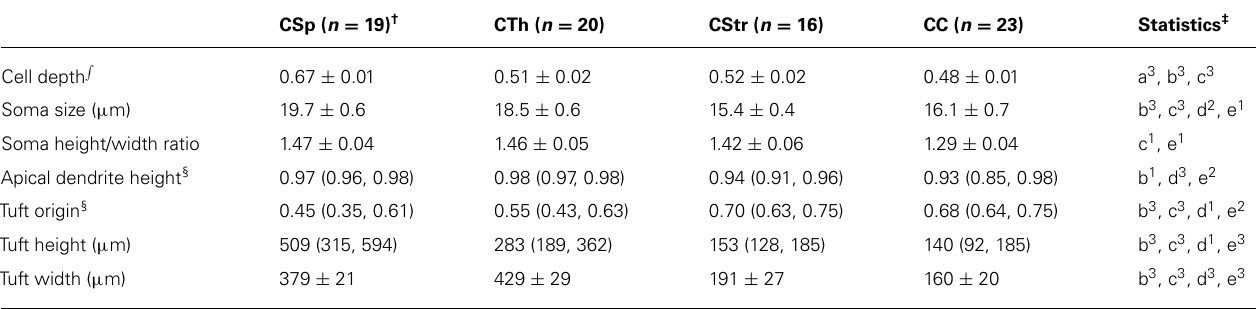
Table 1 | Morphological characteristics of M1 layer 5 projection